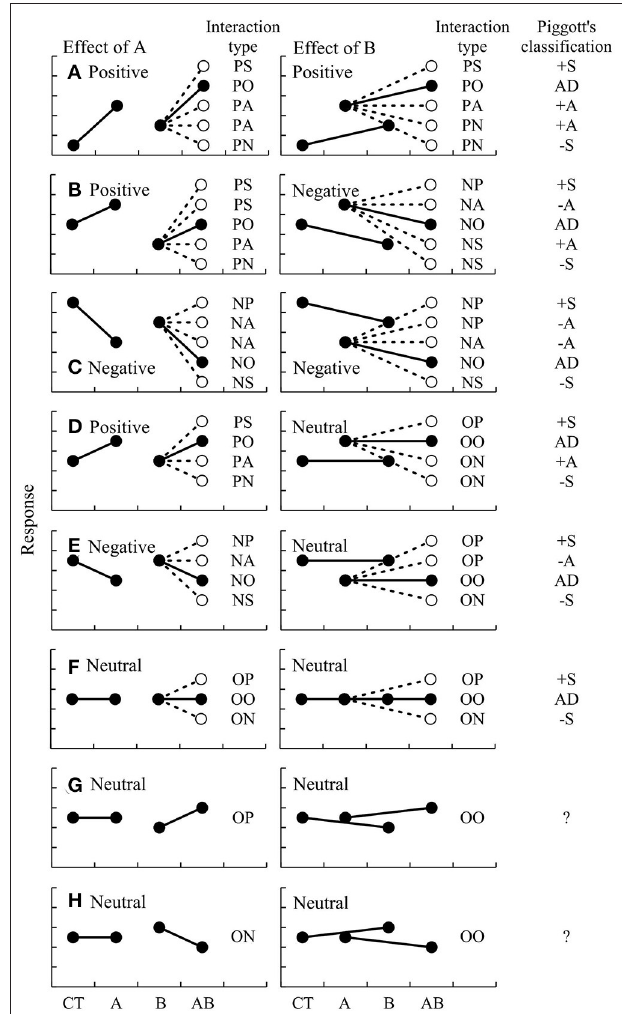
FIGURE 2 | Schematic diagrams of potential types of interactions between two factors, A and B, and comparison with the classification by Piggott et al. (2015) . The changes of A and B are separately shown at left and right, respectively, when the effects of A and B are (A) double positive, (B) opposing, (C) double negative, (D) positive and neutral, (E) negative and neutral, (F–H) double neutral,